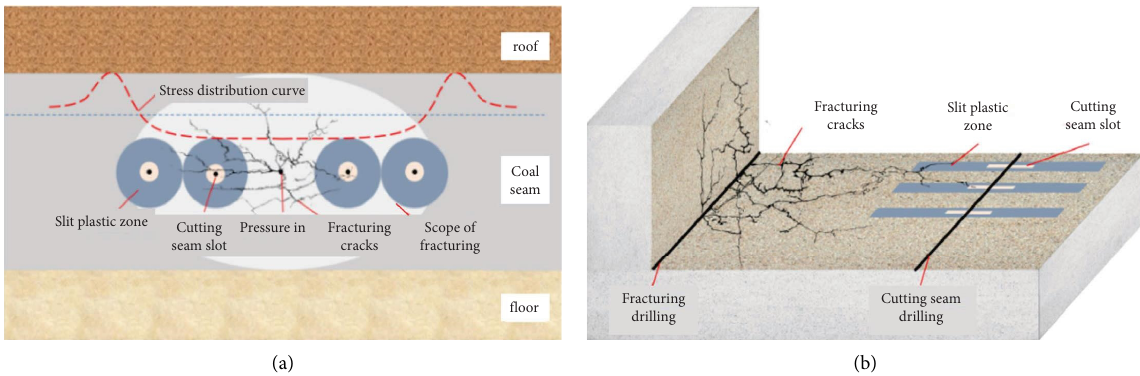
Figure 2: Schematic diagram of high efciency anti-spike mode of pressing before cutting. (a) Schematic diagram of fracture propagation profle after compression. (b) Schematic diagram of the distribution plane of the crack before pressing and cutting.